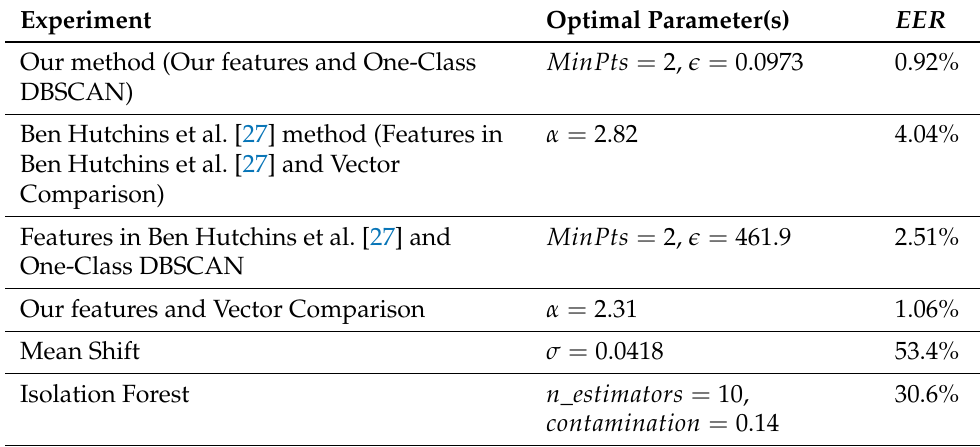
Table 4. Comparison results.